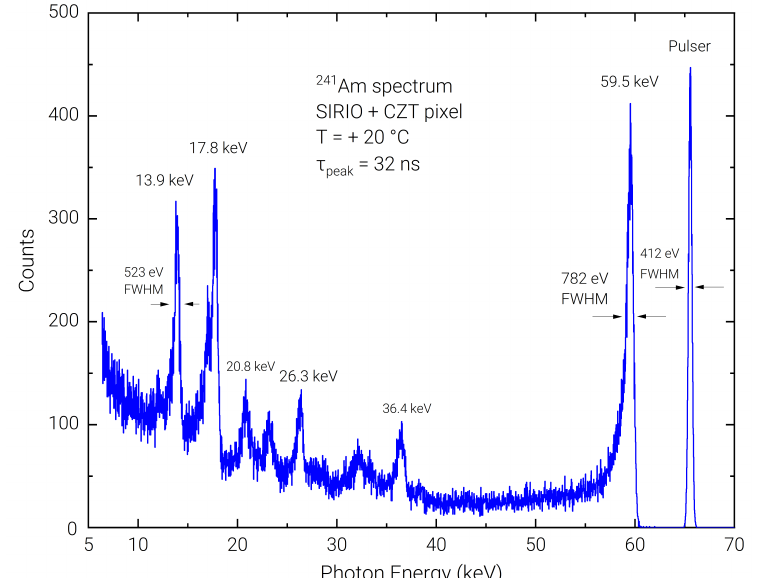
Figure 7. Detail of the room temperature energy spectrum acquired with the 241 Am radioactive with 32 ns peaking time.